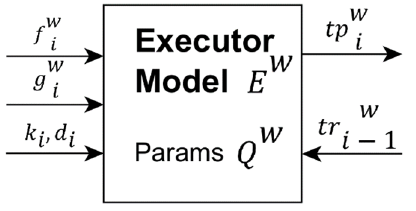
𝐸𝑤 w . Figure 4. The general diagram of the Executor Model E